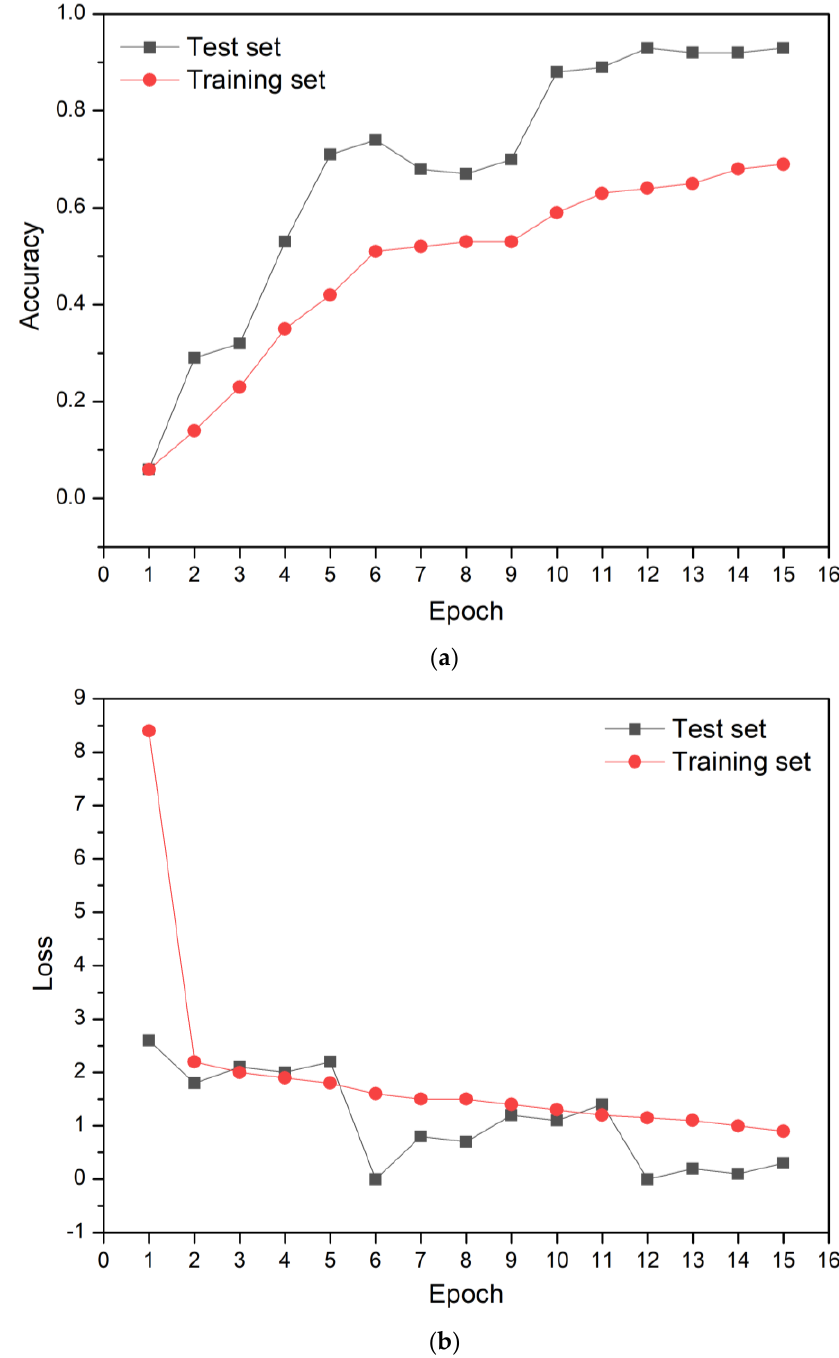
Figure 5. The learning ( a ) accuracy and ( b ) loss of the CNN model for 15 epochs. In contrast, BM, LC2, and LC4 showed lower classification accuracy. For the LC4, it was classified as the LC4 itself eighty-four times. However, it was also predicted as the LC5 (four times), LC7 four times, and LC8 (eight times). These results indicate that the predicted values calculated by the CNN model (15 epochs) were not perfectly equivalent to the true values, resulting in a relatively low classification